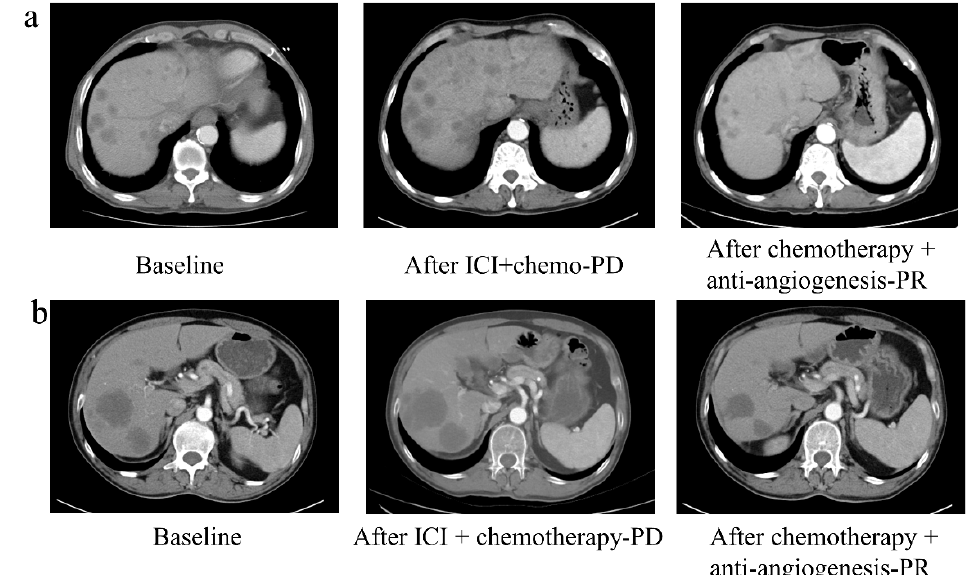
Figure A3. The clinical response of two non-small cell lung cancer (NSCLC) patients with liver metastasis. The clinical response to second-line chemotherapy combined with anti-angiogenesis therapy after failure of first-line PD-1/PD-L1 inhibitors combined with chemotherapy in two NSCLC patients ( a , b ) with liver metastasis. Table A1. Efficacy of PD-1 inhibitors combined with anti-angiogenesis therapy in NSCLC patients with liver metastasis in first-line.